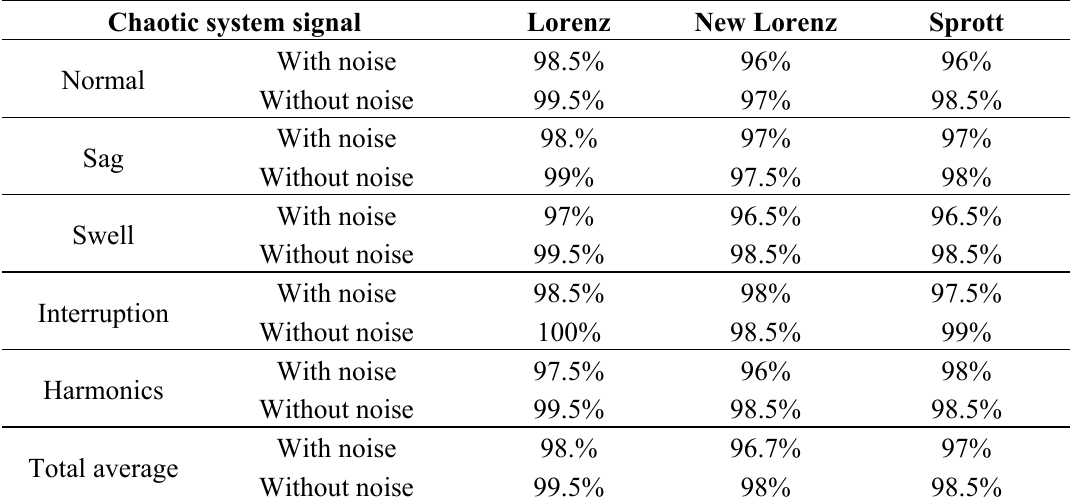
Table 1. Comparison of detection performance of three CS-based